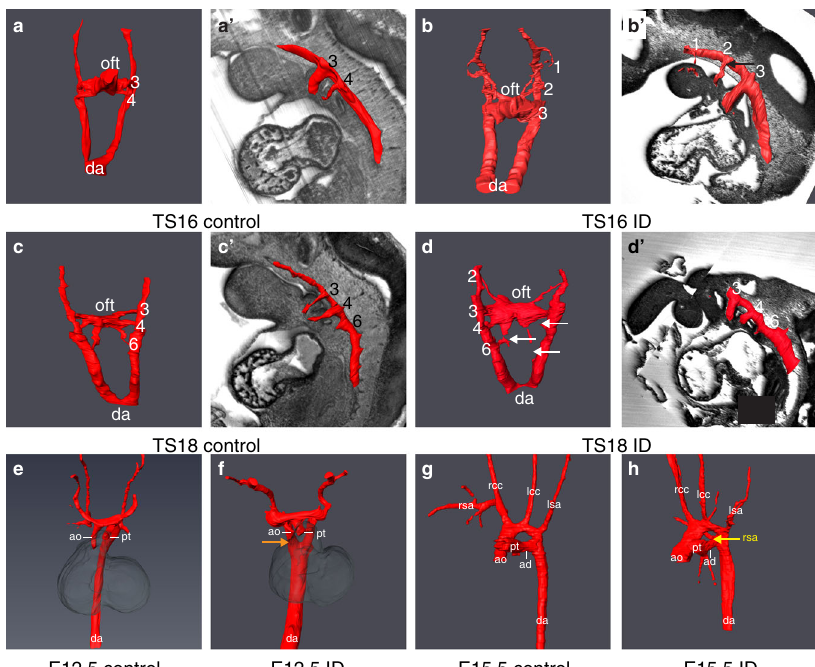
Fig. 2 Maternal ID causes aortic arch abnormalities. Comparison of aortic arch artery morphology between control ( a , c , e , g ) and ID ( b , d , f , h ) embryos. Representative 3D Amira reconstructions from manually segmented HREM data of early E10.5 ( a , b ), late E10.5 ( c , d ), E12.5 ( e , f ) and E15.5 ( g , h ) embryos. For clarity of PAA identity, 3D models of E10.5 embryos are overlaid onto a sagittal section of the same embryo ( a ’ – d ’ ). Persistent PAA2 (panel b ’ , black arrow), interrupted PAA4 and PAA6 (panel d , white arrows), persistent right dorsal aorta (panel f , orange arrow) and aberrant right subclavian artery (panel h , yellow arrow) are indicated. da dorsal aorta, oft out fl ow tract, ao aorta, pt pulmonary trunk, rsa right subclavian artery, rcc right common carotid artery, lcc left common carotid artery, lsa left subclavian artery, ad arterial